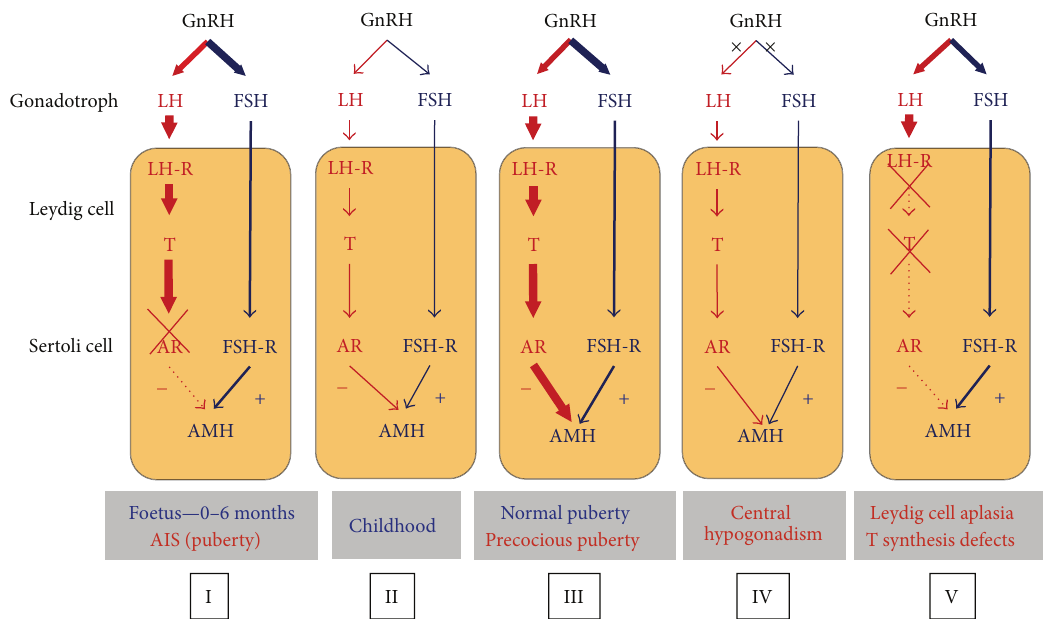
Figure 1: Regulation of testicular AMH secretion by gonadotropins and androgens. In general, the hypothalamus regulates LH and FSH secretion by the gonadotroph through the gonadotropin-releasing hormone (GnRH). LH acts on the LH receptor (LH-R) present in Leydig cells, inducing testosterone (T) secretion. FSH acts on the FSH receptor (FSH-R) present in Sertoli cells. The hypothalamic-pituitary-gonadal axis is active in the foetus and early infancy, is quiescent during childhood, and is reactivated at puberty. FSH is a moderate inducer of AMH secretion, whereas T, acting through the androgen receptor (AR), is a potent inhibitor of AMH production. In the normal foetus and infant, as well as in patients with the androgen insensitivity syndrome (AIS), the lack of AR expression results in high AMH production by Sertoli cells (I). During childhood, there is a physiologic hypogonadotropic state resulting in very low T; AMH levels remain high, but somewhat lower probably due to the lack of FSH stimulus (II). In normal or precocious puberty, T prevails over FSH, resulting in AMH inhibition (III). In congenital central hypogonadism, AMH is lower than in the normal boy because of the longstanding lack of FSH from foetal life; however, at pubertal age, the inhibitory effect of T is also absent, and AMH remains higher than in normal puberty (IV). In Leydig cell-specific primary hypogonadism (Leydig cell aplasia or hypoplasia due to LH-R defects or defects of steroidogenesis), the inhibitory effect of androgens is absent, and AMH levels are high. The orange area represents the testis. Thickness of lines is in correlation with hormone effect on its target. From [5], Copyright Karger AG, 2010, with